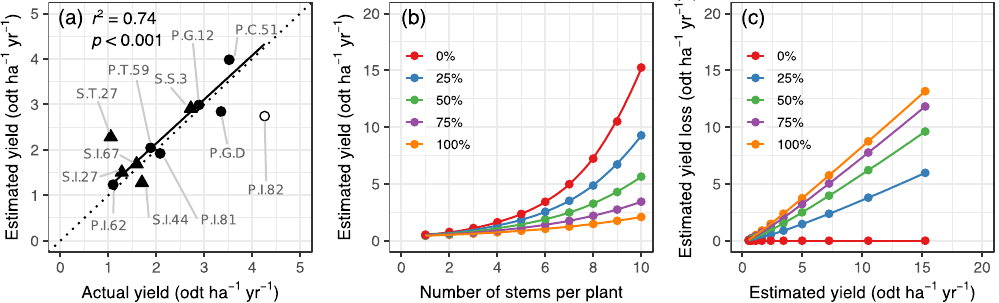
Figure 4. Relationship between actual and estimated willow yield with reference to deer browsing, using a generalized linear model (GLM) ( a ), and GLM simulations for estimated yield with browsing ( b ) and estimated yield loss due to browsing ( c ), assuming 0%, 25%, 50%, 75%, and 100% of browsed stems per plant. In panel ( a ), circles and triangles represent Salix pet-susu and S. sachalinensi clones, respectively; and an open symbol represents the clone that were determined to be an outlier based on the GLM residuals. Clone names are shown. The coe ffi cient of determination ( r 2 ), level of significance ( p ), and regression line of the standardized major axis analysis for 11 clones excluding an outlier clone are also shown in panel ( a ). The dotted line represents a 1:1 relationship. Loess regressions were applied in panels ( b ) and ( c ). odt, oven dry ton.